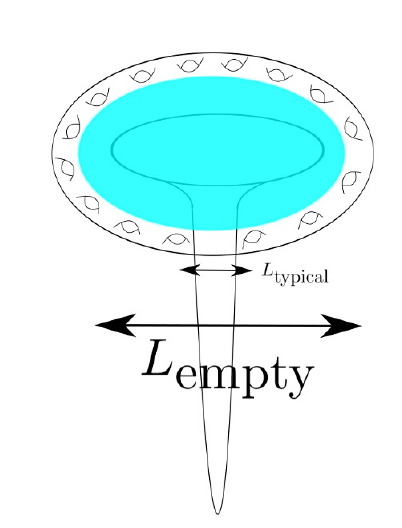
Figure 7 . We depict a cartoon of a CY manifold that would evade our conclusions. There exists a large topologically trivial area in the interior where a large KS throat can (cid:12)t. All of the topological structure is densely aligned around